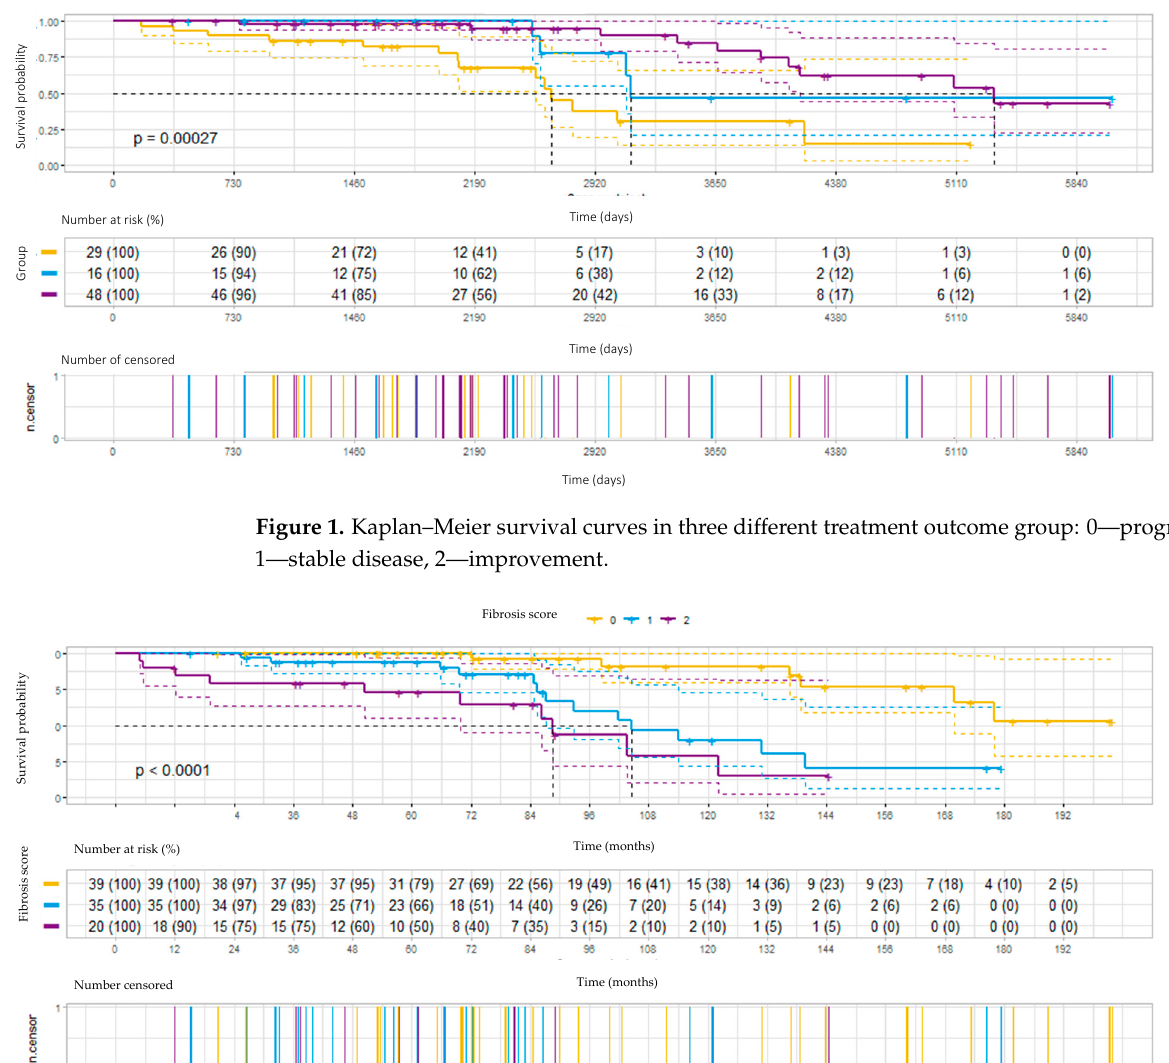
Figure 2. Kaplan–Meier survival curves according to the HRCT fibrosis score. Figure 2. Kaplan – Meier survival curves according to the HRCT fibrosis score. Fibrotic lung disease was combined with a significant worsening in survival (Figure 1). Significant positive prognostic indicators were VCmax > 65% pred., TLC > 72.5% 249 Median survival times in the patients with fibrosis scores of 0, 1, and 2 were over 170 months pred. and positive response to treatment. Significant negative prognostic indicators were 250 (median not reached), 104 months, and 88 months, respectively ( p < 0.0001). fibrotic changes in HRCT (p<0.001) (Table 5).6). Response to treatment or stabilization during therapy was combined with a significant survival advantage (Figure 2). Median survival times in the patients who responded Table 6. Predictors of survival (univariate Cox regression analysis). to treatment, who were stable, or who progressed were 178 months, 104 months, and 88 months, respectively ( p =